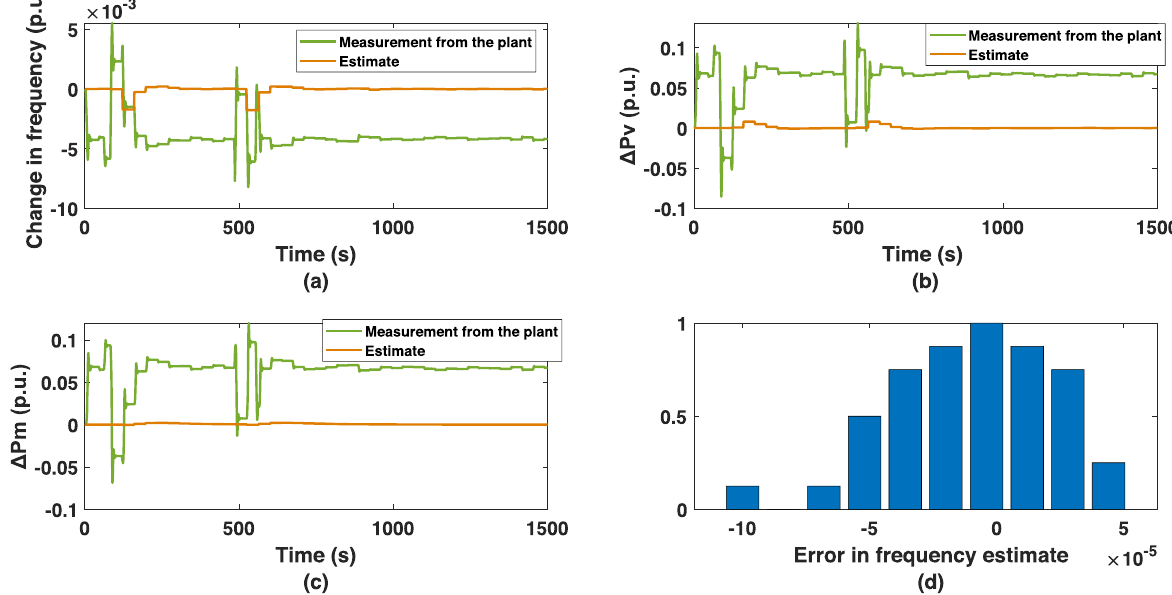
Fig. 6 a , b and c Variation of states Δ f, Δ P v and Δ P m in response to disturbance along with the estimate from the observer; d Normalized histogram of error in frequency estimate for a measurement noise variance of 0.005